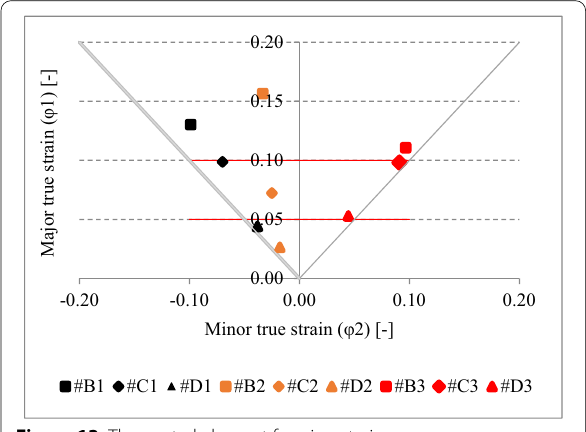
Figure 13 The central element forming strain